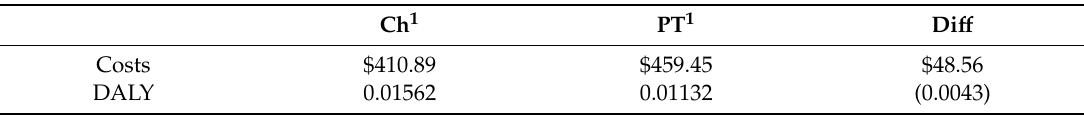
Table 3. The cost-e ff ectiveness